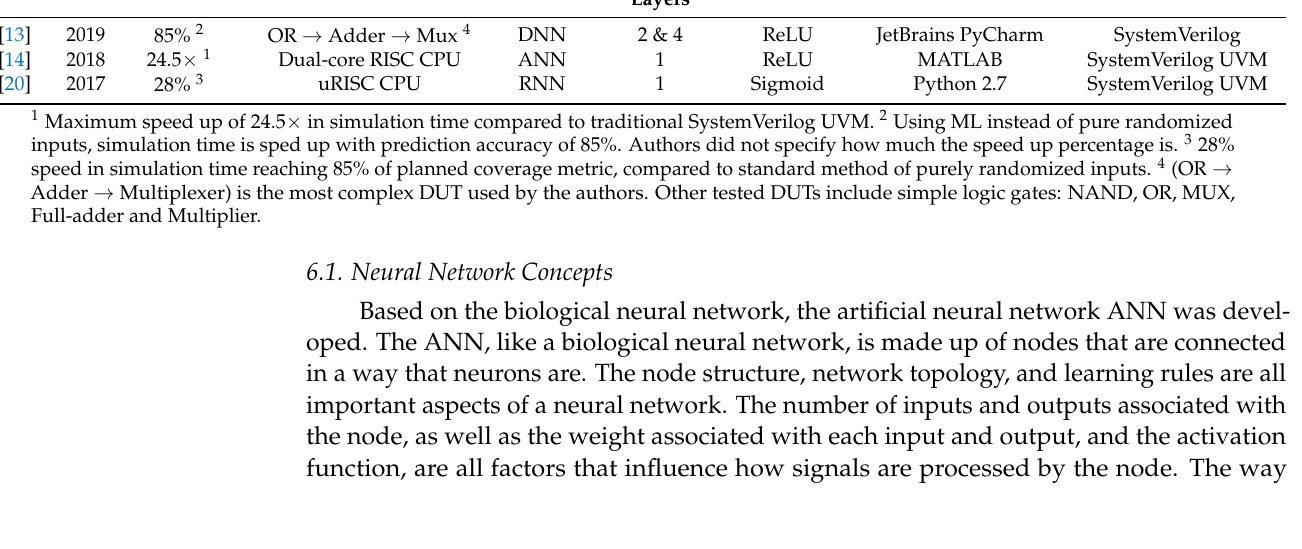
Table 6. Comparative Summary of NN contributions in Section 6.